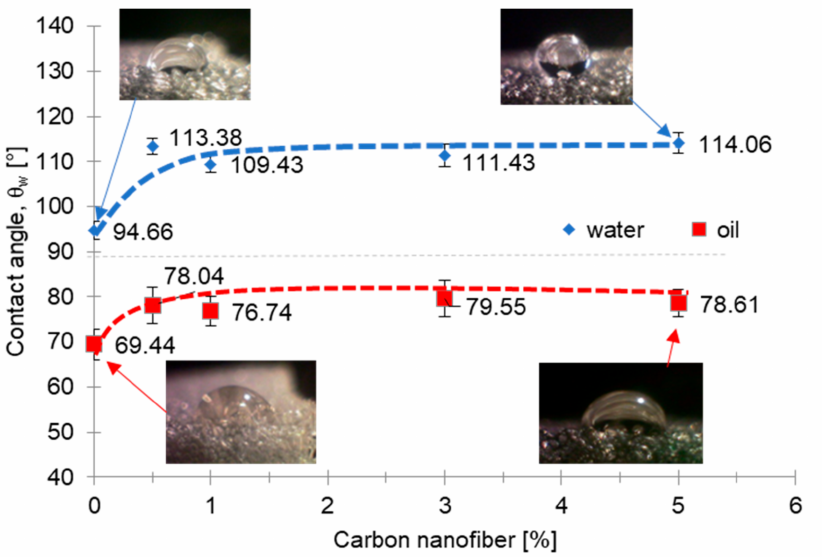
Figure 4. Wenzel contact angle of water and oil of the sponges at different CNF content with the image of the liquid droplets at the lowest (0%) and at the highest (5%) filler amount. Each value is the average of ten measurements and the amplitude of its error bar is two times the corresponding standard